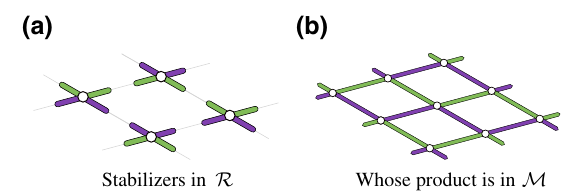
FIG. 13. The bulk of the logical membranes. Both m X , X and m Z , Z from Eq. (14) are elements of the surviving stabilizer R ∩ M . They can be constructed from stabilizers of the six-ring resource states in such a way that they also clearly belong to the measurement group. Purple and green full (half) edges represent XX ( X ) and ZZ ( Z )